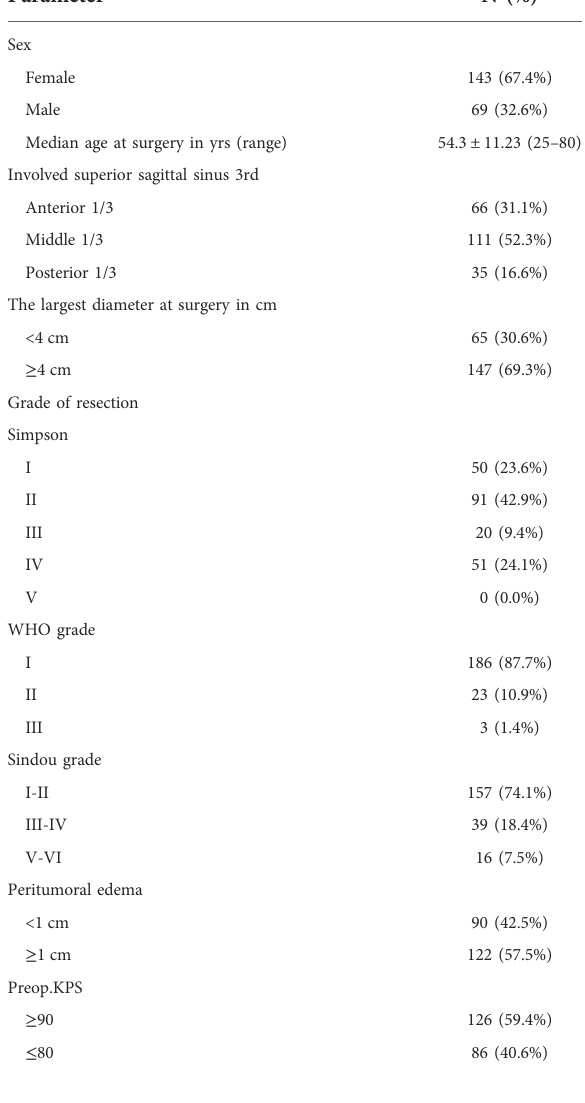
TABLE 1 Features and outcomes of 212 patients with superior parasagittal